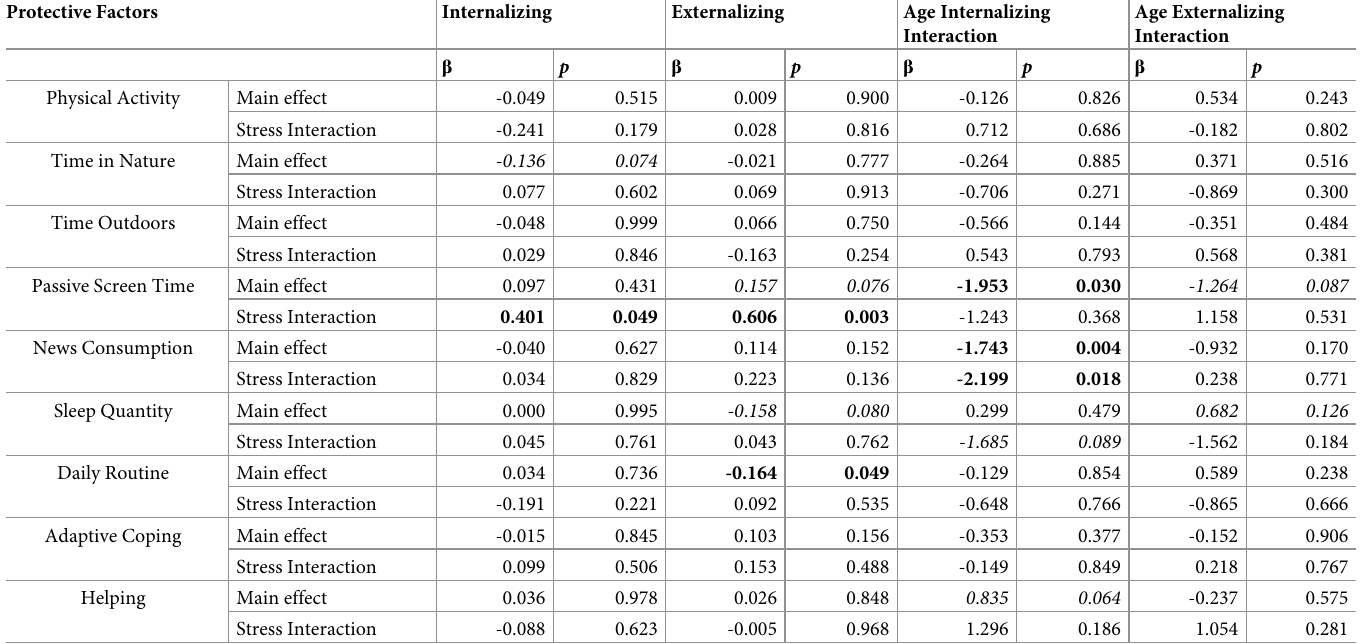
Table 3. Associations of potential protective factors with psychopathology and interactions with stress and age at T2. Significant associations are presented in BOLD and marginal associations are presented in